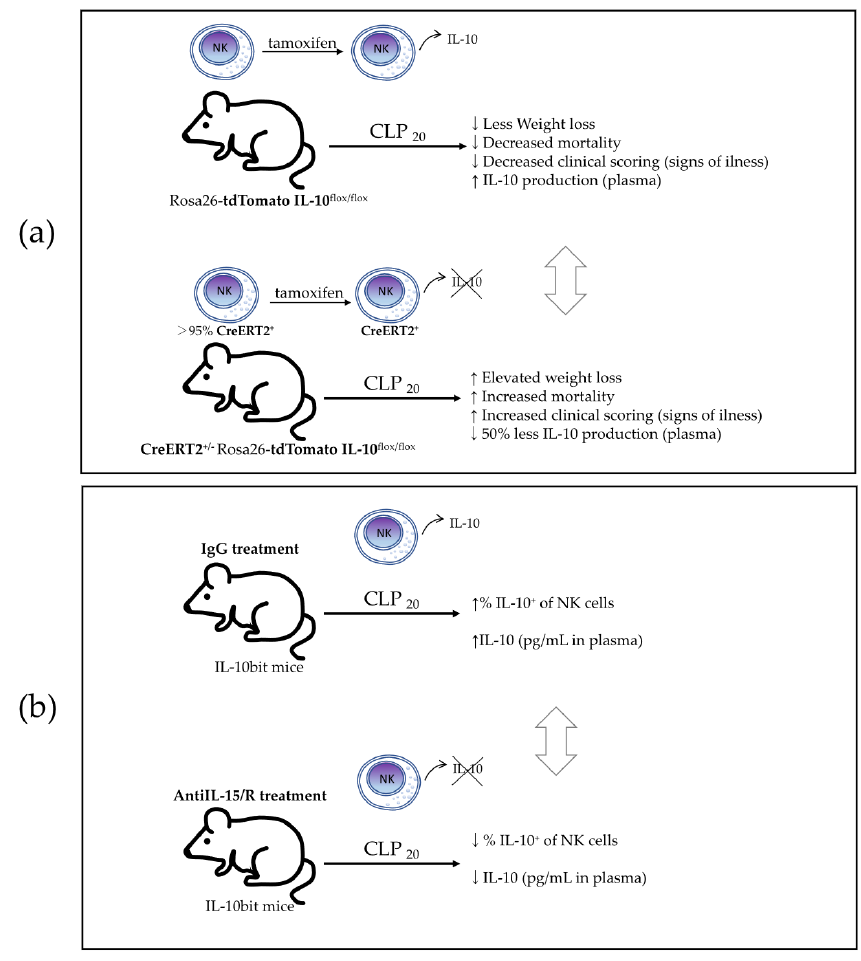
Figure 6. NK cell-derived IL-10 supports host survival during sepsis, which is produced in an IL-15-dependent manner. The role of NK cell-derived IL-10 was investigated by using a cecal ligation and puncture (CLP) model of sepsis induction in mice. ( a ) IL-10-deficient NK cell (NCR1-CreERT2 +/2 Rosa26-tdTomatoIL-10f lox/flox ) mice and their control (Rosa26- tdTomato IL-10f lox/flox ) littermates were treated with tamoxifen to knock out IL-10 expression in NK cells expressing the CreERT2, and mortality and morbidity were evaluated after CLP 20 . ( b ) IL-10bit mice (which express Thy1.1 during active IL-10 transcription) were treated with either anti-IL-15/R-blocking antibodies or control IgG, and the frequency and num- ber of IL-10-producing NK cells along with plasma IL-10 concentration were measured. CLP 20 — CLP with 1 puncture (as a model of low severity sepsis).